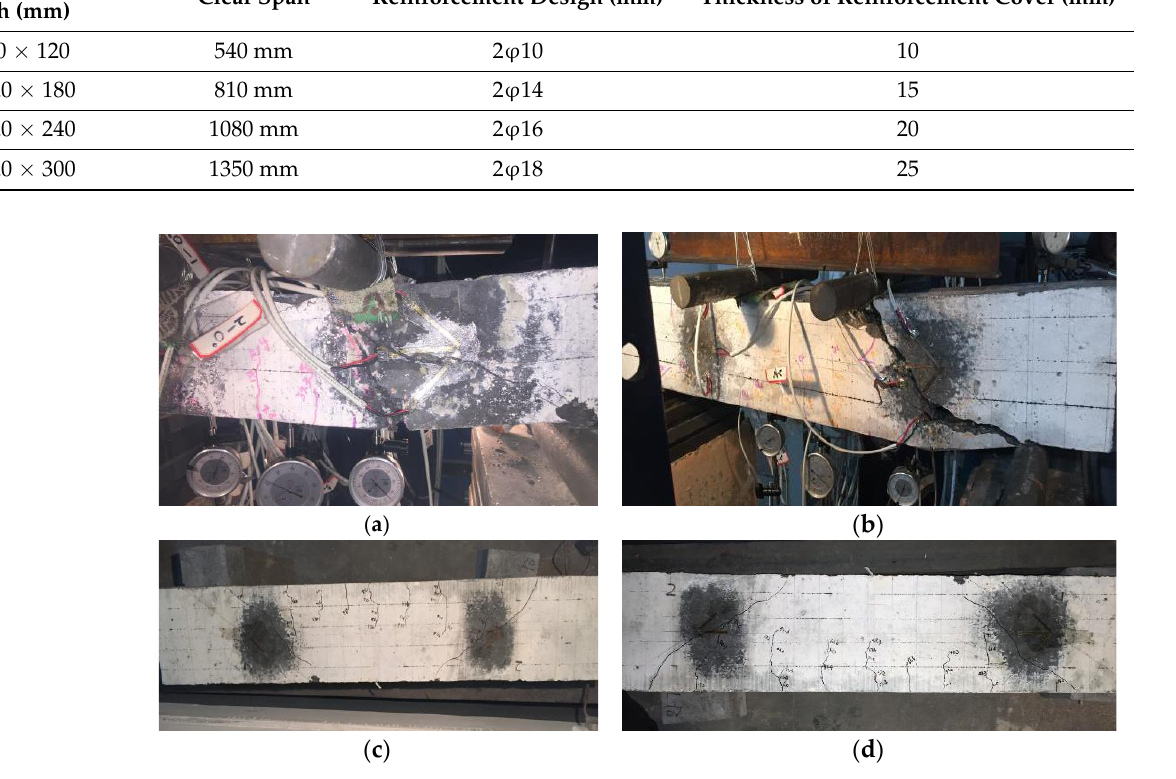
Figure 4. Failure modes of the recycled concrete beams. ( a ) B-740 failure mode. ( b ) B-1010 failure